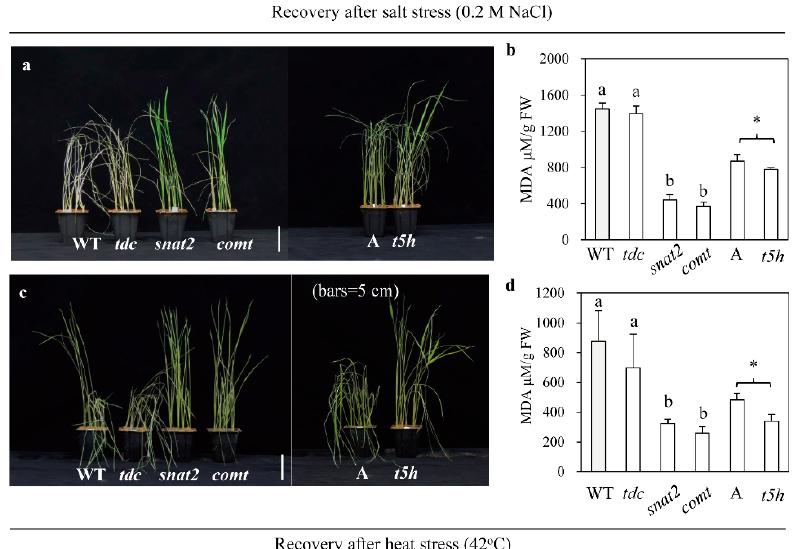
Figure 9. Stress tolerance of melatonin-deficient rice mutant lines. ( a ) Salt-treated rice seedlings. ( b ) MDA levels after salt treatment. ( c ) Heat-treated rice seedlings. ( d ) MDA levels after heat treatment. Methods for salt and heat treatment are described in Figures 6 and 8, respectively. tdc , TD C suppression rice; snat2 , SNAT2 suppression R7 rice; comt , COMT suppression rice; A, Ashahi rice (wild type of t5h mutant rice); t5 h, T5H mutant rice. Different letters and asterisks indicate significant differences as determined by a post-hoc Tukey’s HSD test at p < 0.05.